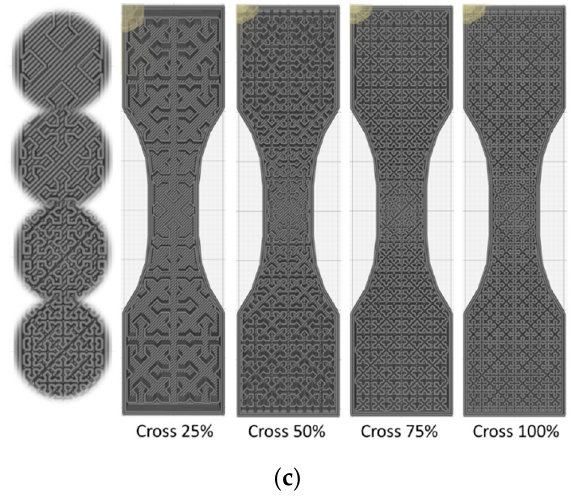
Figure 1. Filling patterns and densities: ( a ) zigzag, ( b ) gyroid, ( c ) cross.